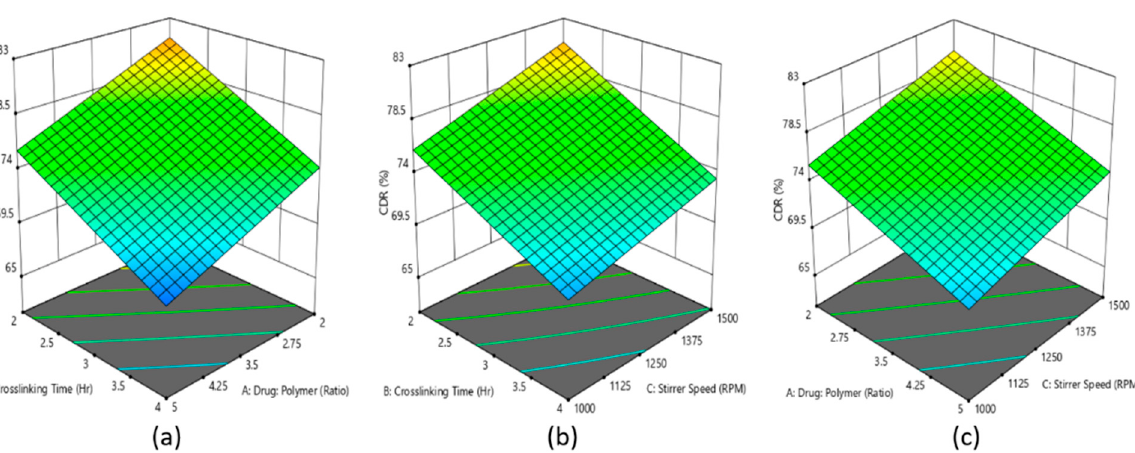
Figure 2. Effect of the interaction of ( a ) drug–polymer ratio, ( b ) crosslinking time, and ( c ) stirrer speed is represented in the 3D surface plot on percentage entrapment efficiency of rivastigmine nanoparticle formulation. The 3D surface plot of % EE in Figure 2 signifies that the drug-to-polymer ratio had a more significant effect on % EE when compared with crosslinking time. As the drug-to- polymer ratio increased from 1:2 to 1:5, % EE increased from 40 to 57, while crosslinking time increased from 2 to 4 h and % EE increased from 40 to 48. These results are in good